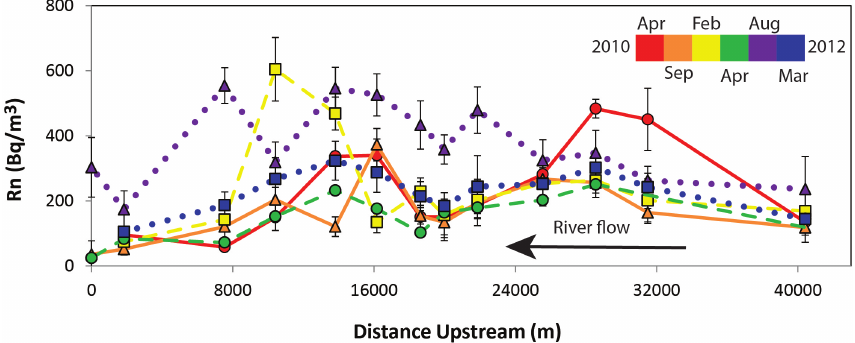
Fig. 3. Distribution of 222 Rn activities in water sampled from the Tambo River over the study period. Apil 2010=solid line with cir- cles, September 2010=solid line with triangles, February 2011=dashed line with squares, Apil 2011=dashed lines with circles, Au- gust 2011=dotted line with triangles, Mach 2012=dotted line with squares.